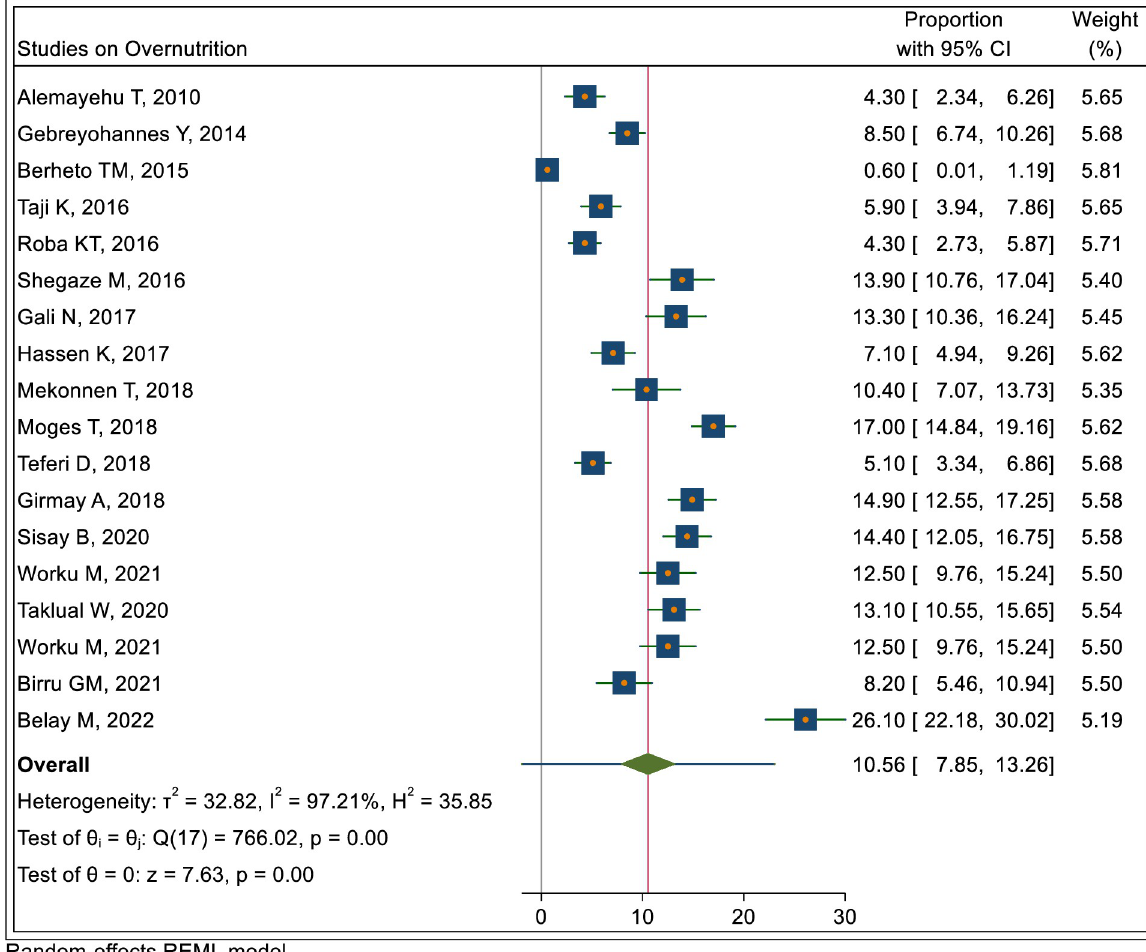
Fig 4. Pooled prevalence of overnutrition (overweight/obesity) in